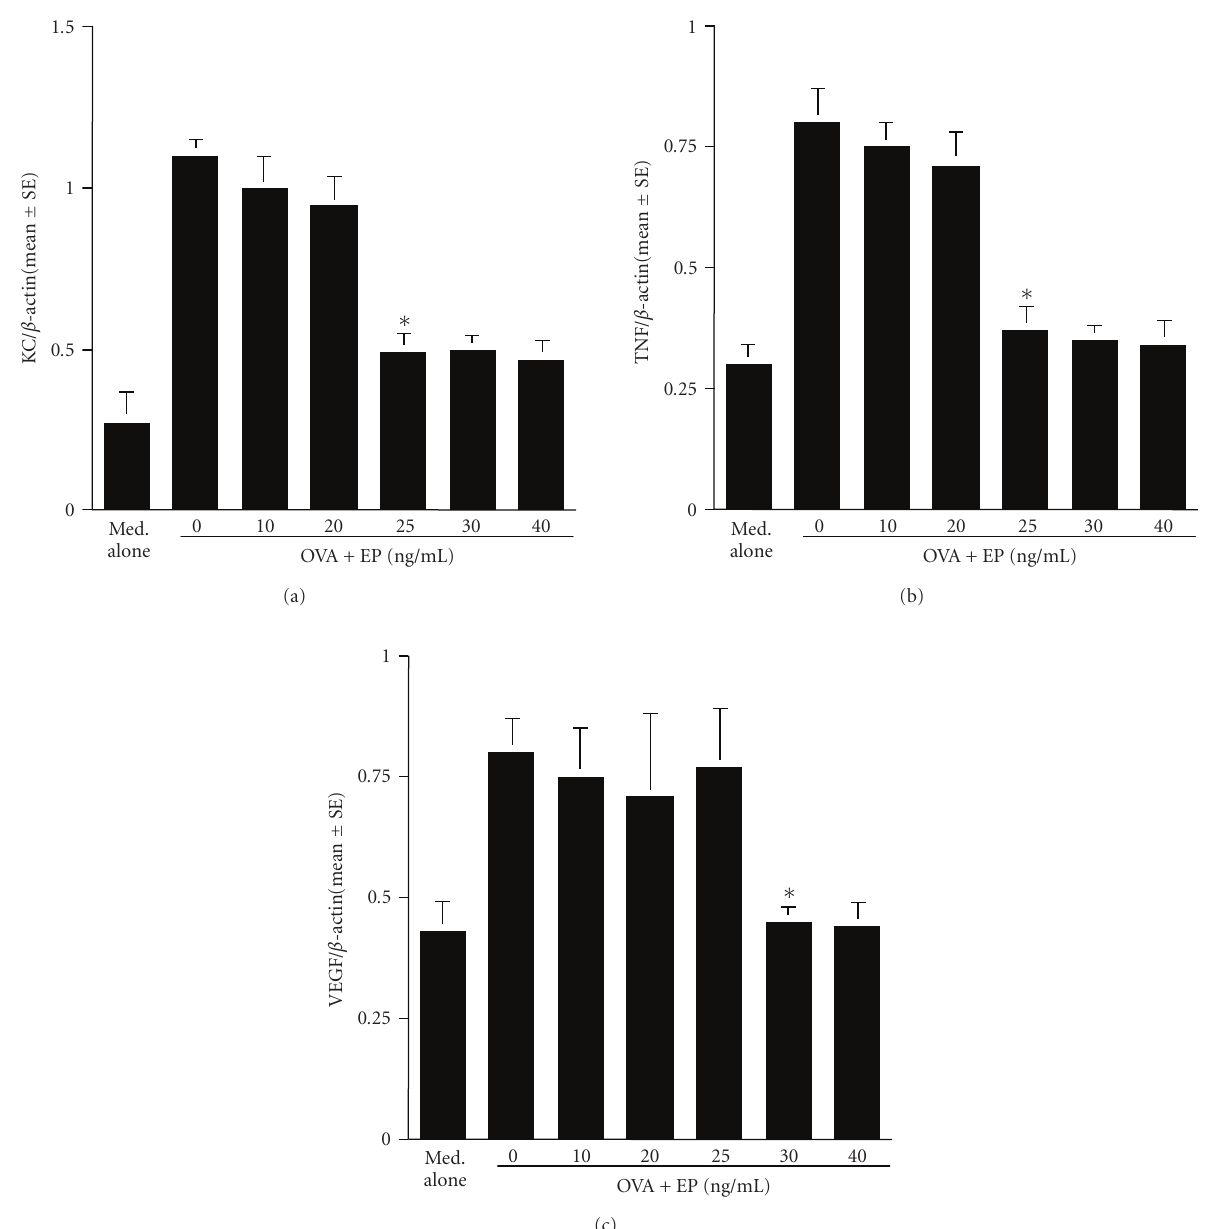
Figure 3: Suppressive activity of epinastine hydrochrolide (EP) on mRNA expression for angiogenic factors in mast cells in IgE-mediated mechanism. Murine peritoneal mast cells (5 × 10 5 cells/mL) sensitized with IgE specific for ovalbumin (OVA) were stimulated with 10ng/mL OVA for 4 hours. mRNA expression for angiogenic factors was examined by real-time RT-PCR. The data are expressed as the mean ± SE of triplicate cultures. KC: keratinocyte-derived chemokine (a); TNF: TNF- α (b); VEGF: vascular endothelial growth factor (c); ∗ P < . 05 versus control (EP at 0